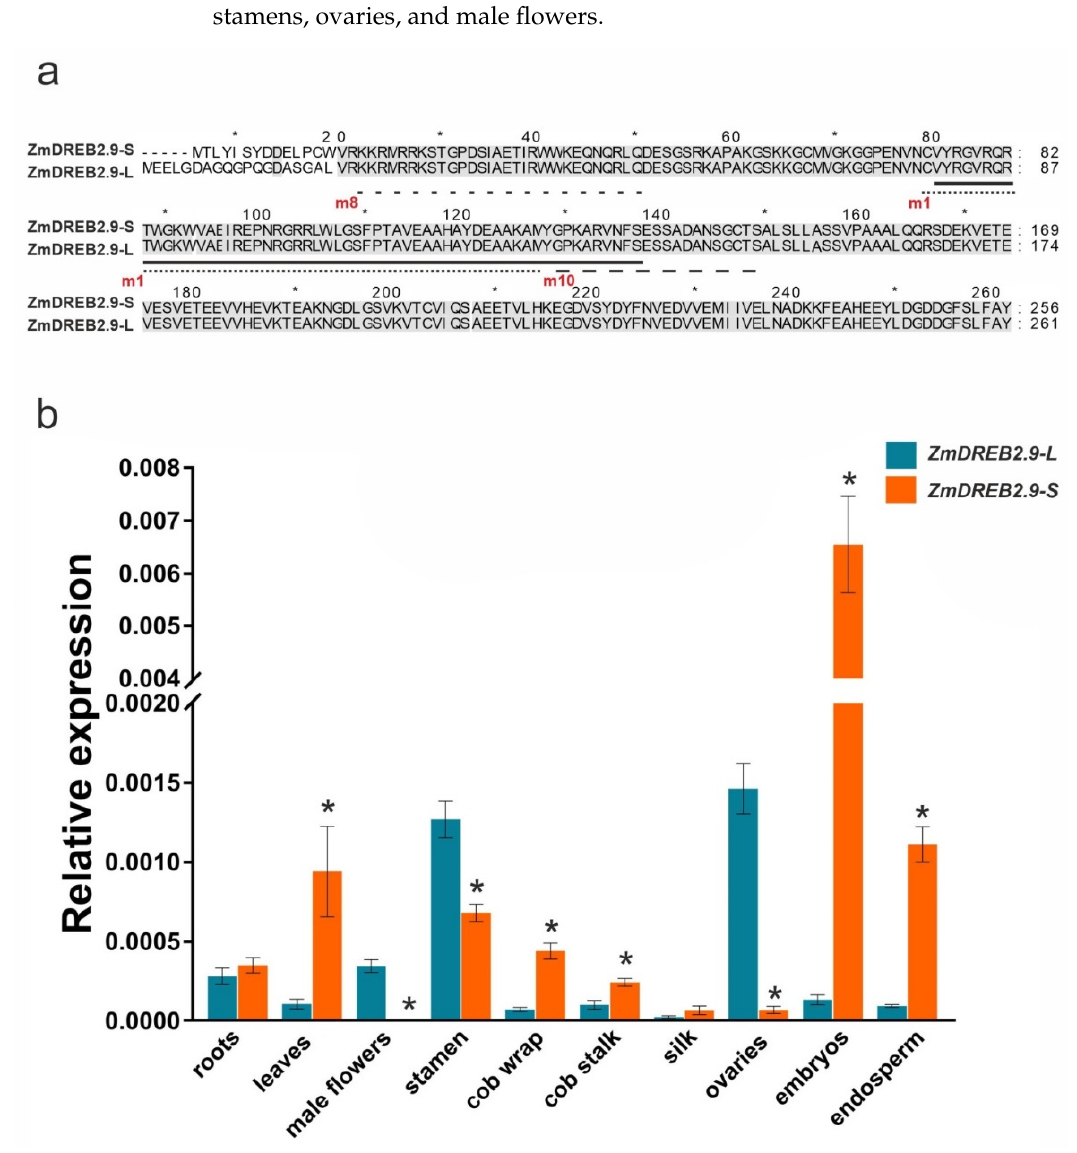
Figure 3. Comparison of ZmDREB2.9 isoforms ZmDREB2.9-L and ZmDREB2.9-S . ( a ) Sequence alignment of ZmDREB2.9-S and ZmDREB2.9-L ; 100% identical regions are highlighted gray, and the AP2 domain is underlined with a solid line. The sequences of motif 8 (m8; see Figure 2b), fol- lowing the area of ZmDREB2.9 alternative splicing, as well as motifs 1 (m1) and 10 (m10), com- prising the AP2 domain, are shown by a dotted lines ( b ) Transcript levels of ZmDREB2.9-L and ZmDREB2.9-S in the indicated Z. mays cv. B73 tissues. The data were normalized to the mRNA expression of the ZmUBC gene (GRMZM2G419891) and presented as the mean ± SD ( n = 3); * p < 0.01.